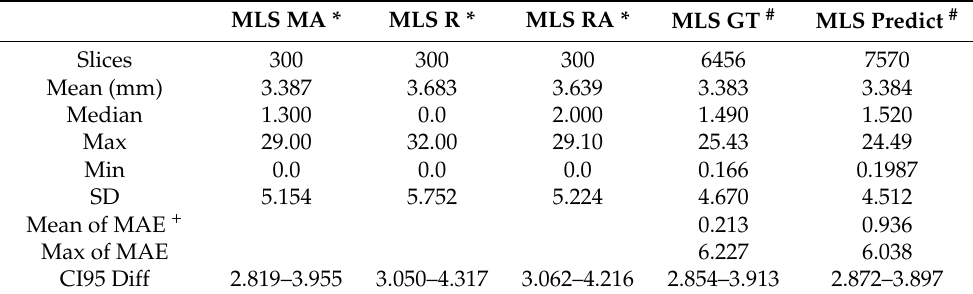
Table 3. Different methods for midline shift measurement.